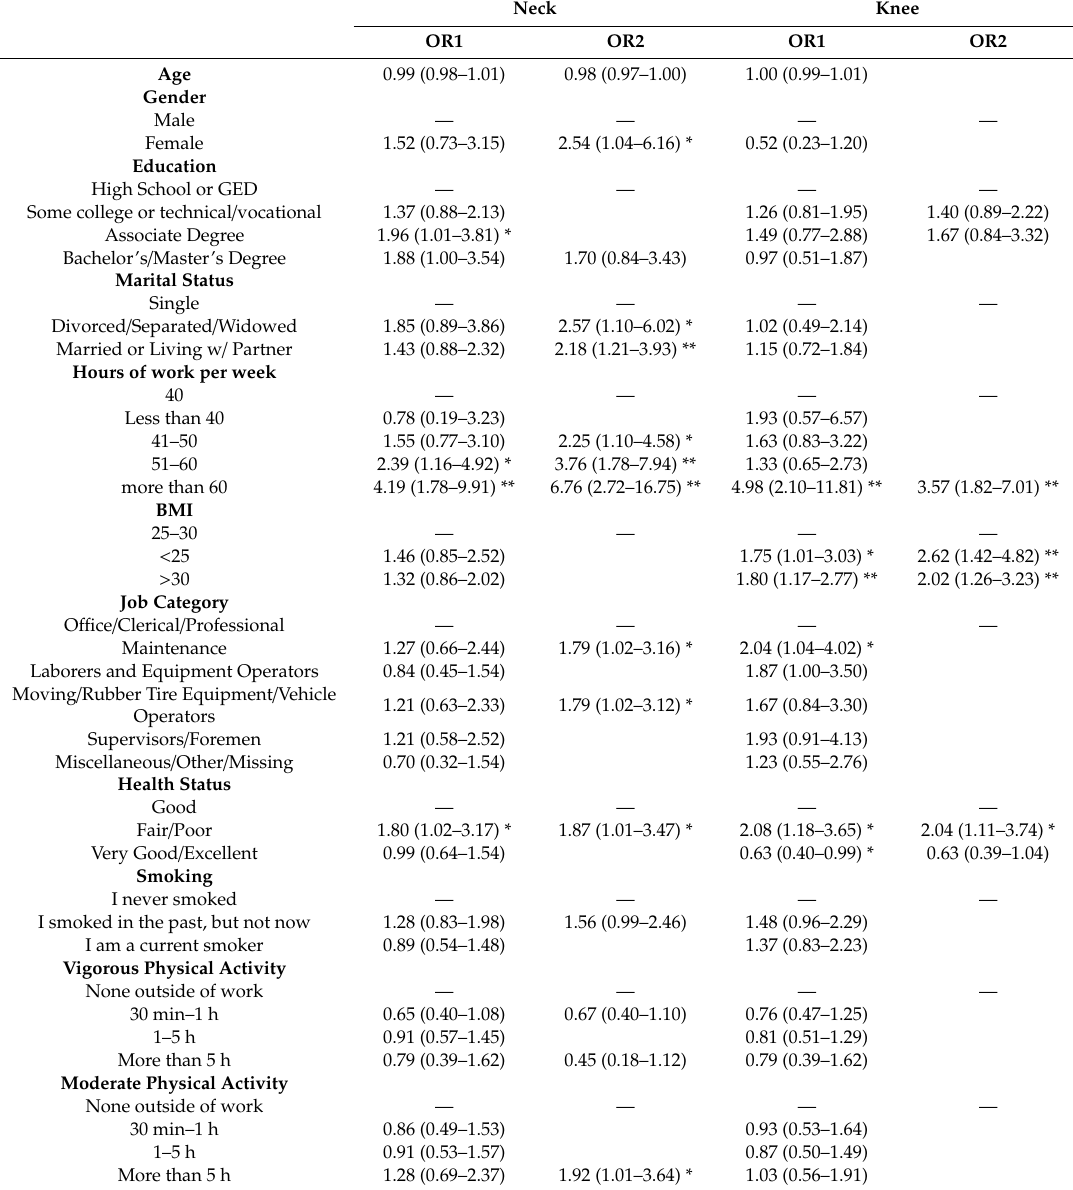
Table 3. Odds Ratios and 95% Confidence Intervals for Neck and Knee